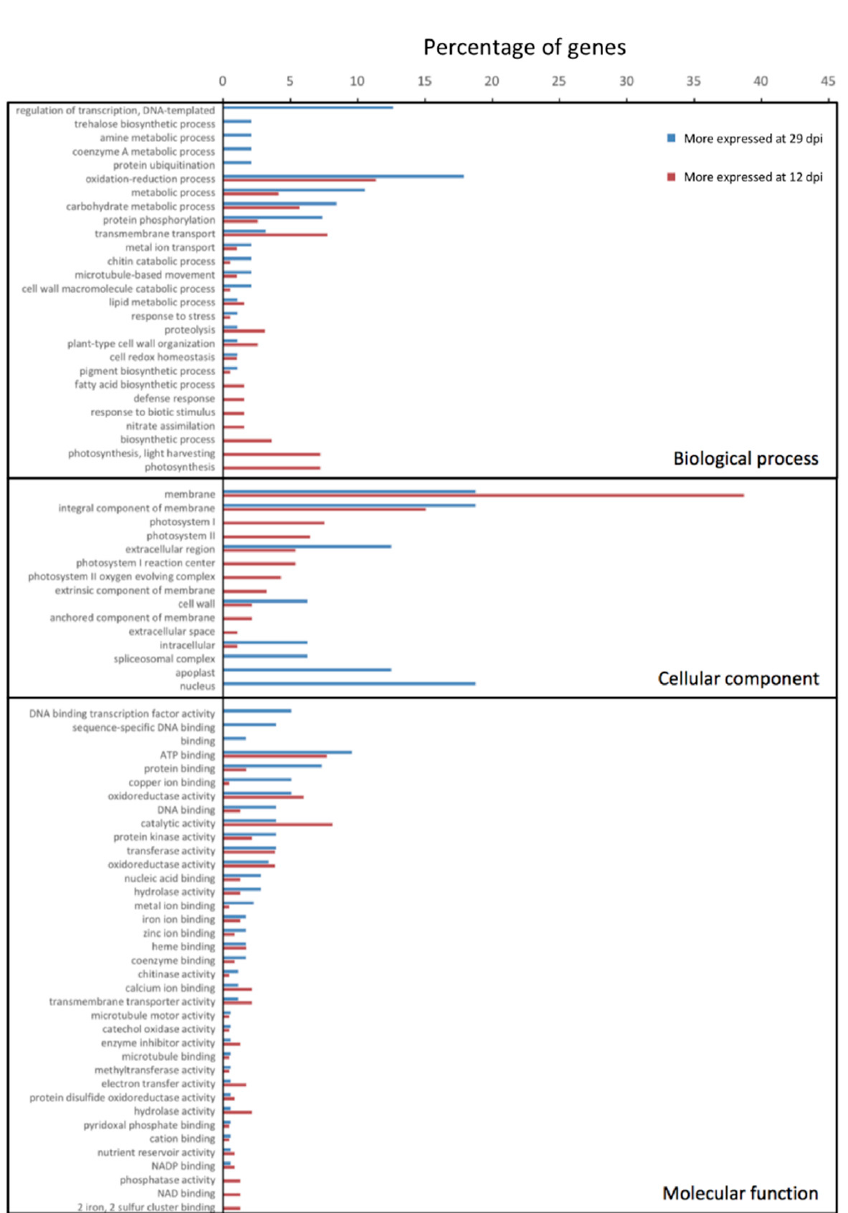
Figure 4. Gene ontology (GO) categories differentially expressed between 12 and 29 days post inoculation (dpi) in Fragaria × ananassa . The most represented categories from all three classes of GO annotations (i.e., biological process, cellular component, molecular function) are represented as a percentage of genes per